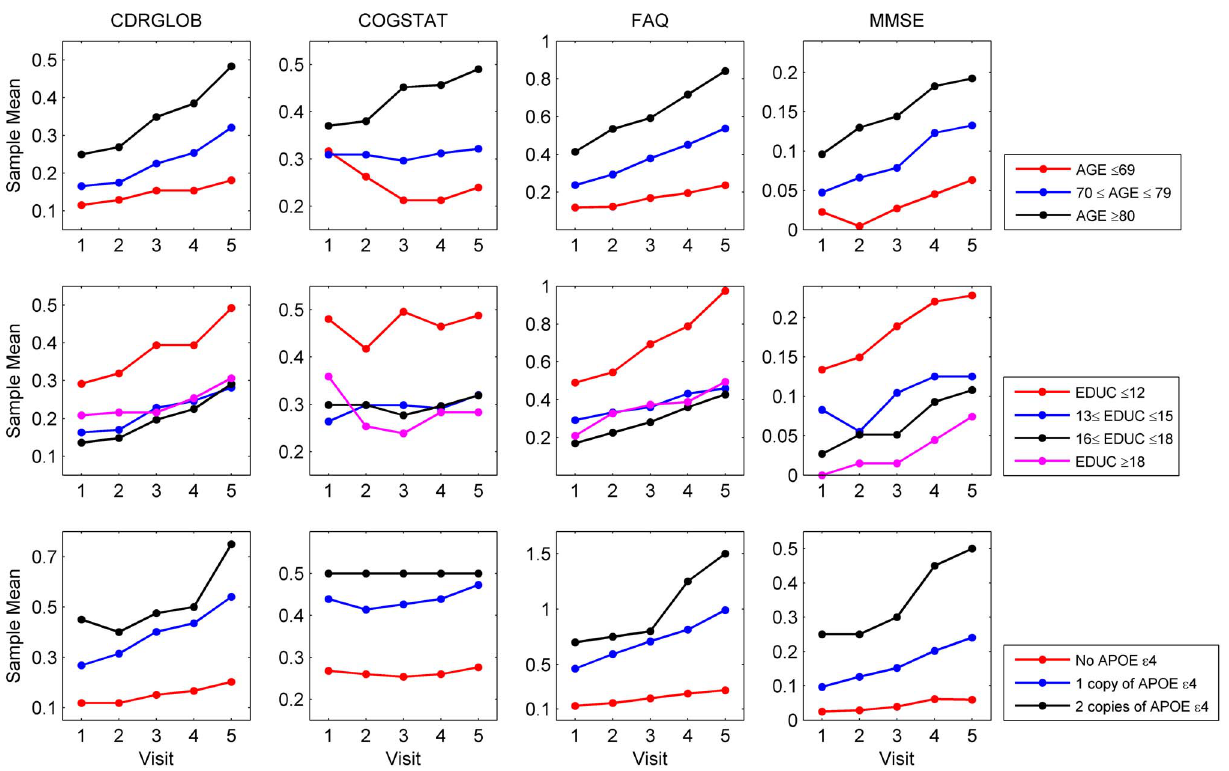
Figure 1. The Alzheimer’s disease data: Sample means of four responses in each group presented by age, years of education and the number of copies APOE- e 4.